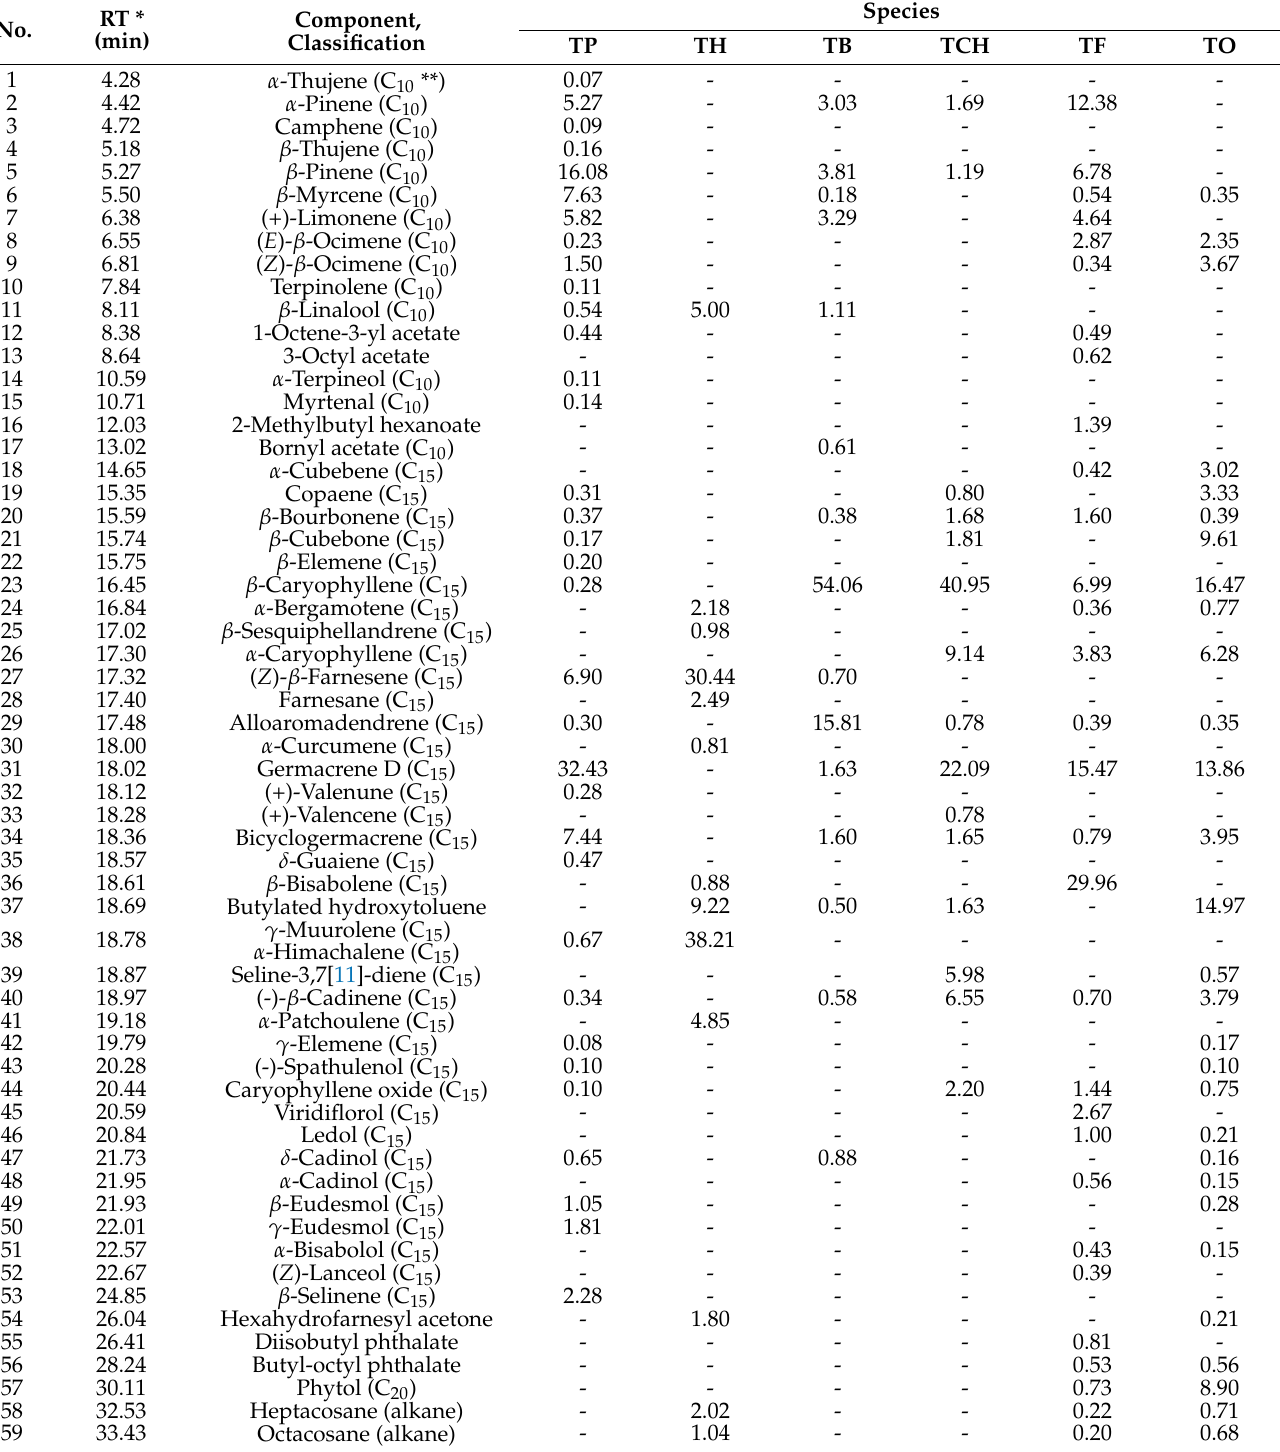
Table 1. Chemical composition of essential oil from Teucrium species grown in